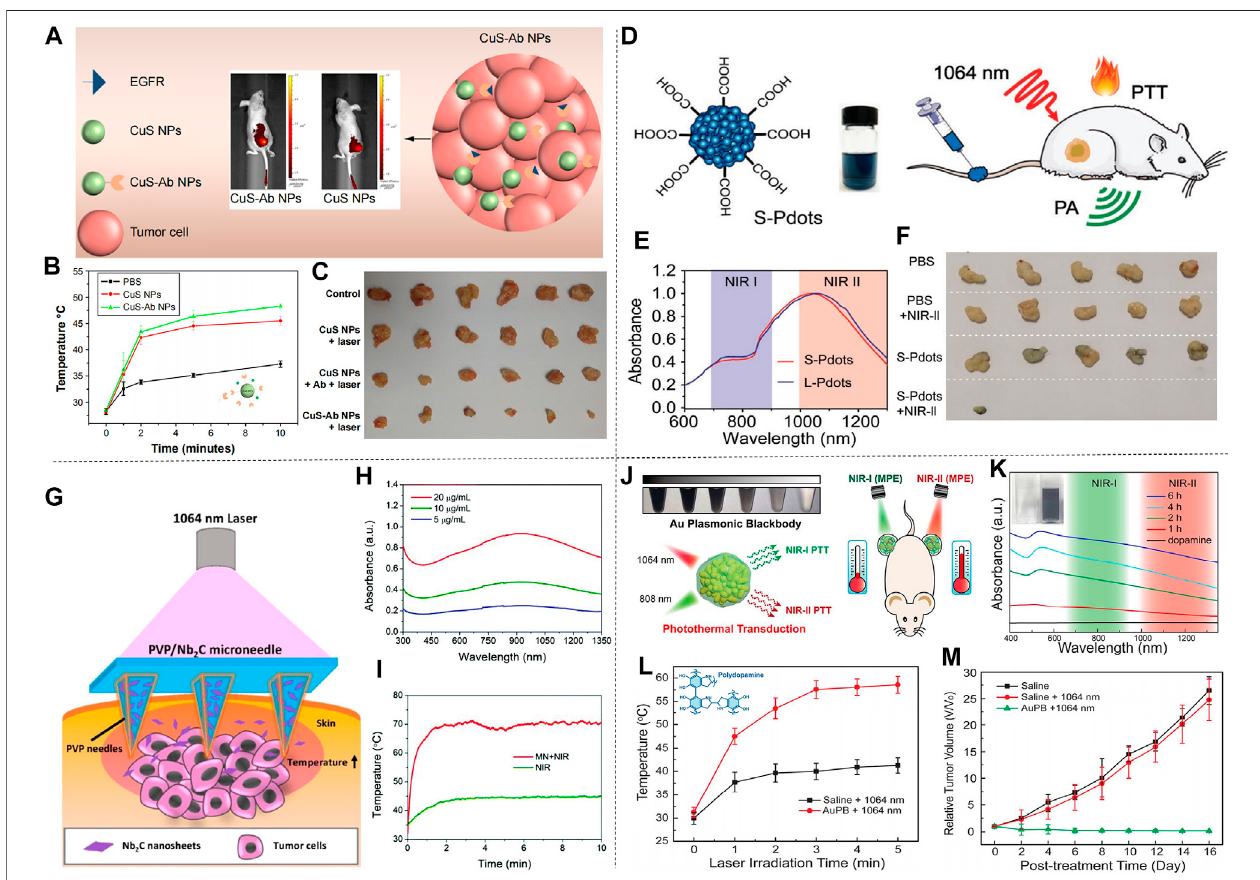
FIGURE 7 | Treatment effect of mice with 4T1 breast cancer cells. (A) Illustration of CuS-Ab NPs ’ target tumor. (B) Tumor temperature change curve in mice after treatment with CuS NPs and CuS-Ab NPs. (C) Photos of tumors during treatment in four groups of mice (reproduced from (Li et al., 2018) with permission from Dove MedicalPress Ltd.). (D) Molecularstructure diagram ofDPP-BTzTD Pdots and its use for PTT. (E) NIR absorptionspectraof S-Pdots and L-Pdots. (F) Tumors cutfrom mice in different groups (reproduced from (Men et al., 2020) with permission from Wiley-VCH Verlag). (G) Diagram of 2D MXene-based therapeutic microneedle patch used for super fi cial tumor phototherapeutics. (H) The UV-vis-NIR absorption spectra of MN in different concentration. (I) Tumor temperature change curve in NIR group and MN + laser group (reproduced from (Lin et al., 2020) with permission from Royal Society of Chemistry). (J) Schematic of AuPBs under NIR laser. (K) UV-vis- NIR absorption spectra of dopamine and AuPBs in different condition. (L) Temperature change curve of tumor in two groups. (M) Relative Tumor growth curve of three group after treatment (reproduced from (Zhou et al., 2018) with permission from American Chemical Society).